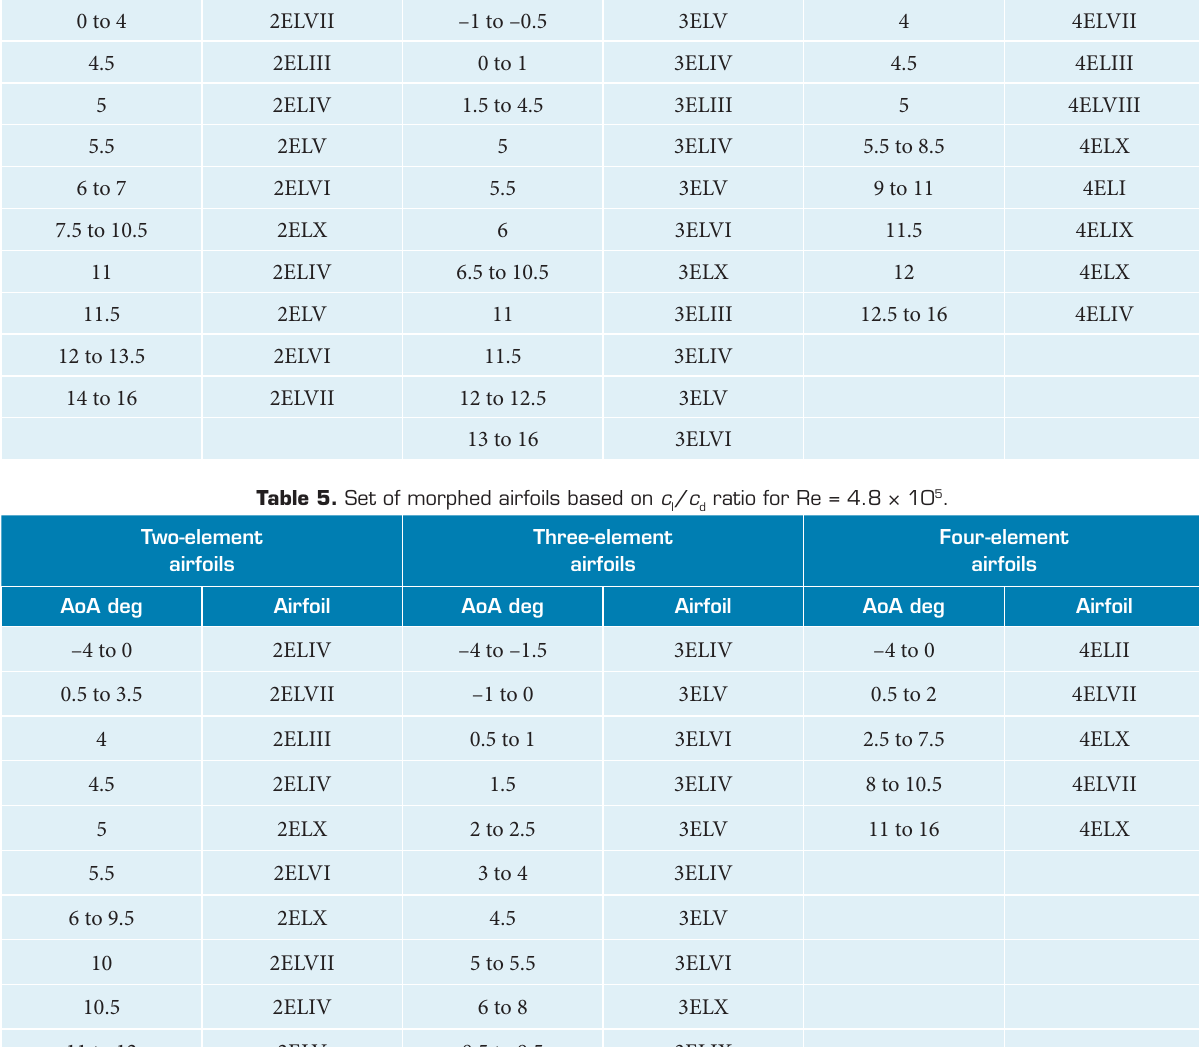
Table 4. Set of morphed airfoils based on c